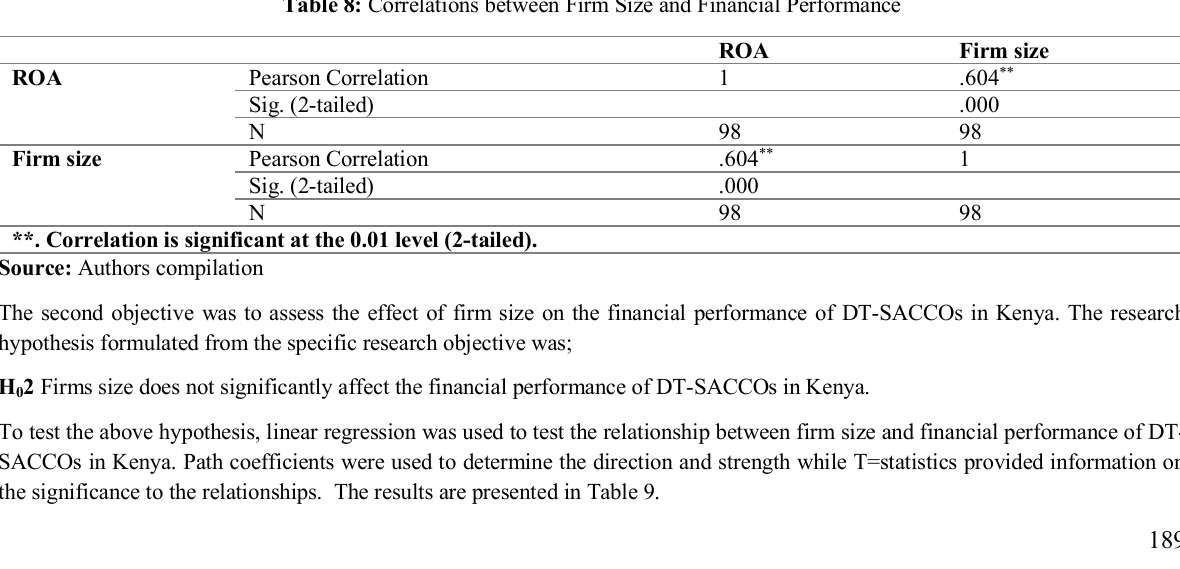
Table 8: Correlations between Firm Size and Financial